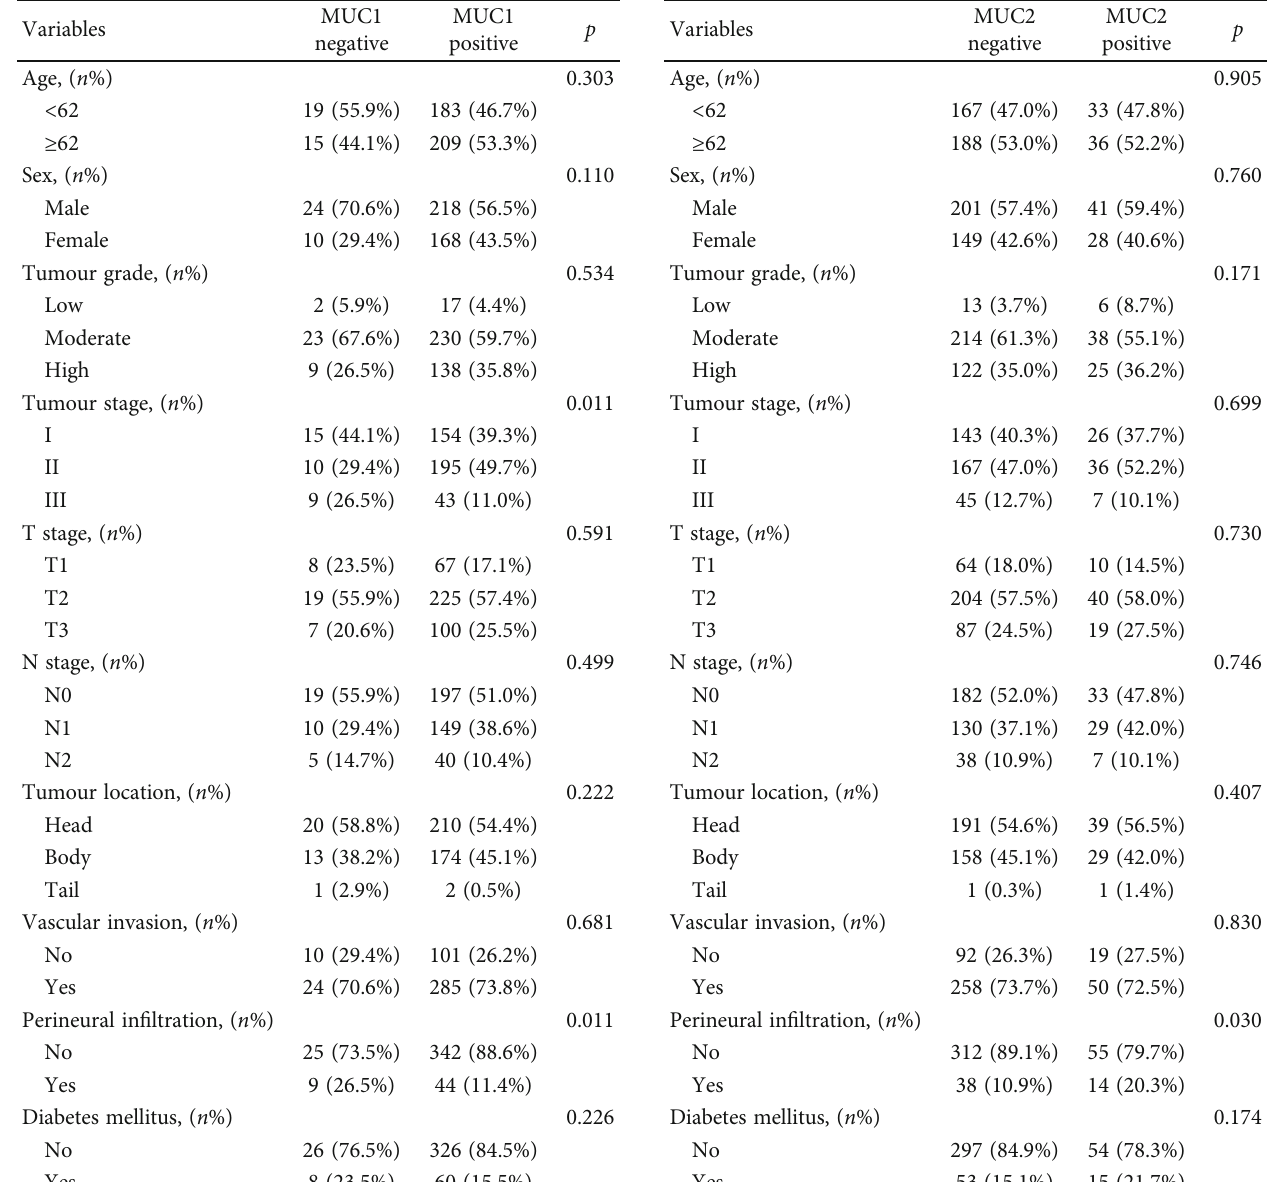
Table 1: Clinicopathological characteristics of FUSCC PDAC patients strati fi ed by MUC1 expression.